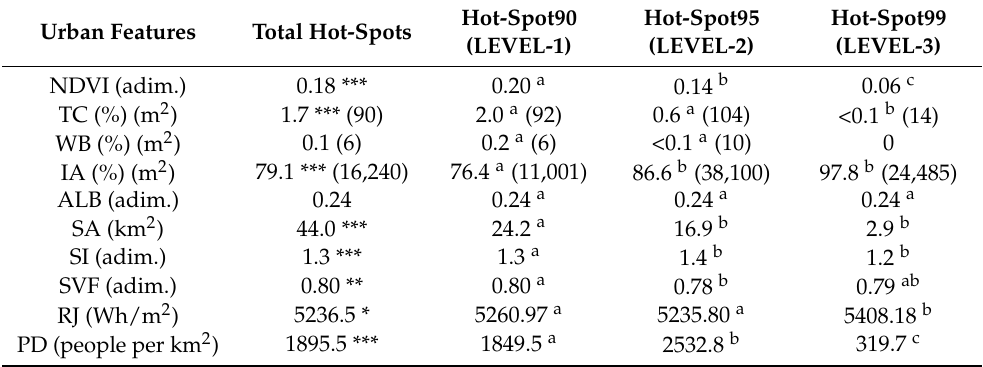
Table 5. Averaged values of urban features in hot-spot classes, with the exception of the sum of surface